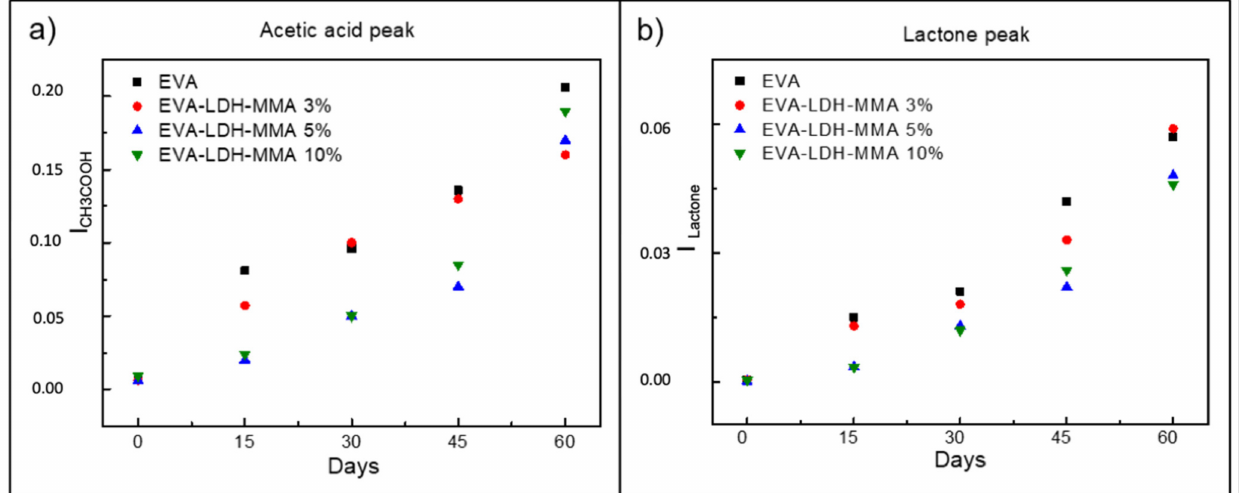
Figure 5. Absorbance values in FT-IR registered at different exposure times for ( a ) acetic acid and ( b ) lactone groups with the EVA samples and the samples of EVA + LDH-MA at different